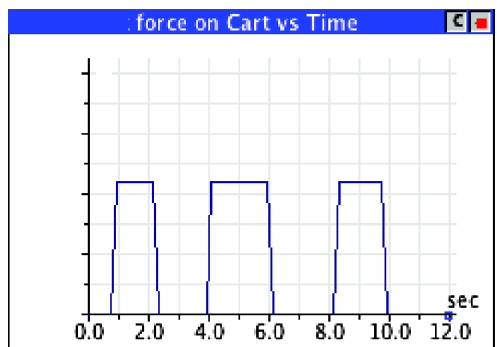
FIG. 2 (color online). Simulator generated force-time graph corresponding to the speed-time graph in Fig.